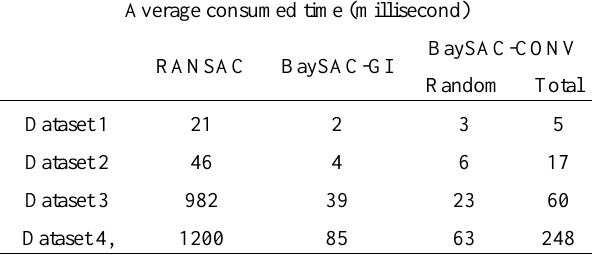
Table 7. Computational efficiency comparison